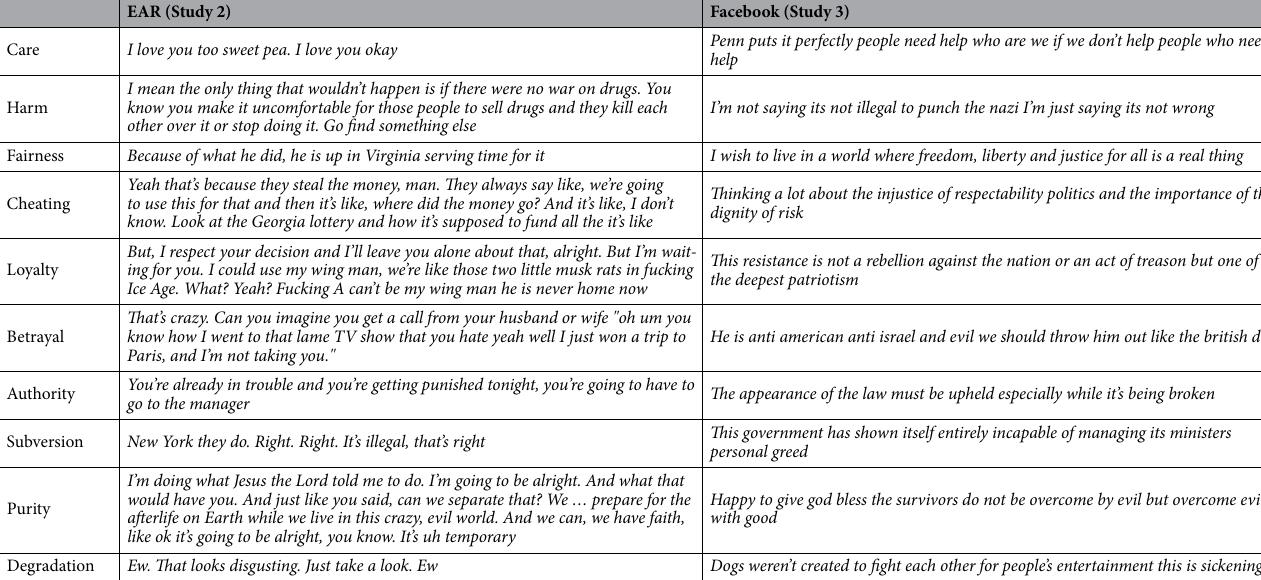
Table 1. Examples from the EAR (Study 2) and facebook (Study 3)